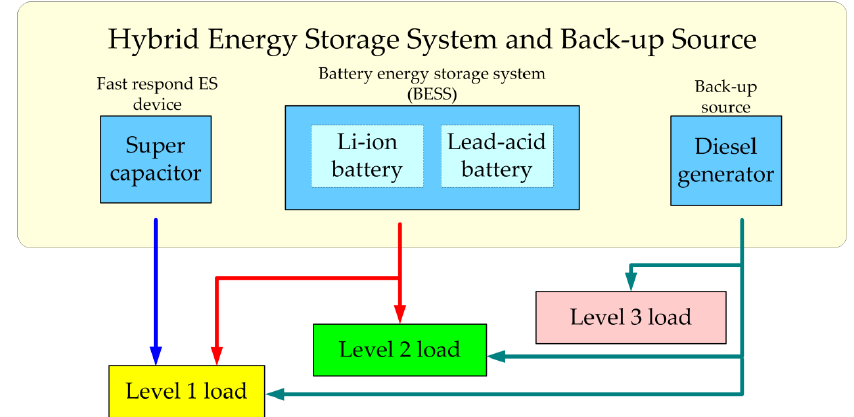
Figure 4. Principle of source-load coordination. ES, energy